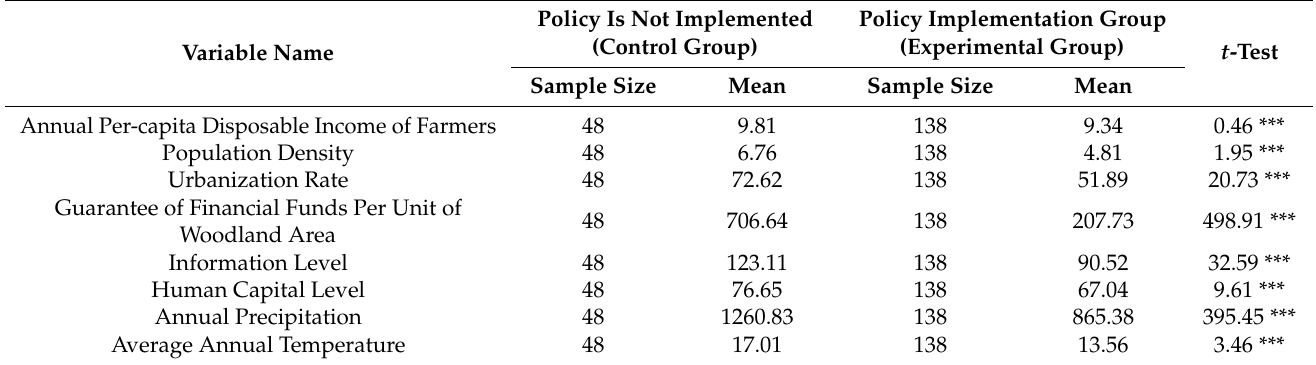
Table 3. Differences in economic and social development between the experimental group and control group.